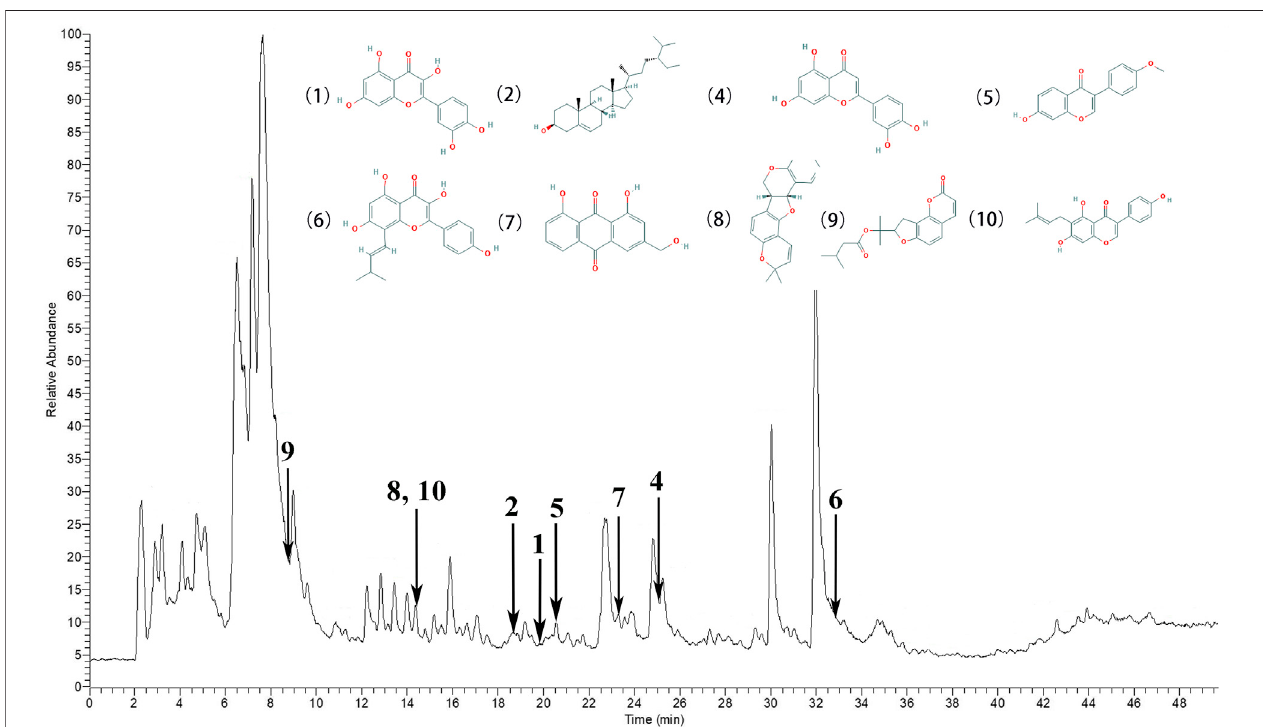
FIGURE 8 | The peaks in the Q Exative chromatogram. The Q Exactive MS of the QXWWD (1) quercetin, (2) beta-sitosterol, (4) luteolin, (5) formononetin, (6) 8- Isopentenyl-kaempferol, (7) aloe-emodin, (8) phaseolin, (9) o -Isovalerylcolum bianetin, (10) wighteone.